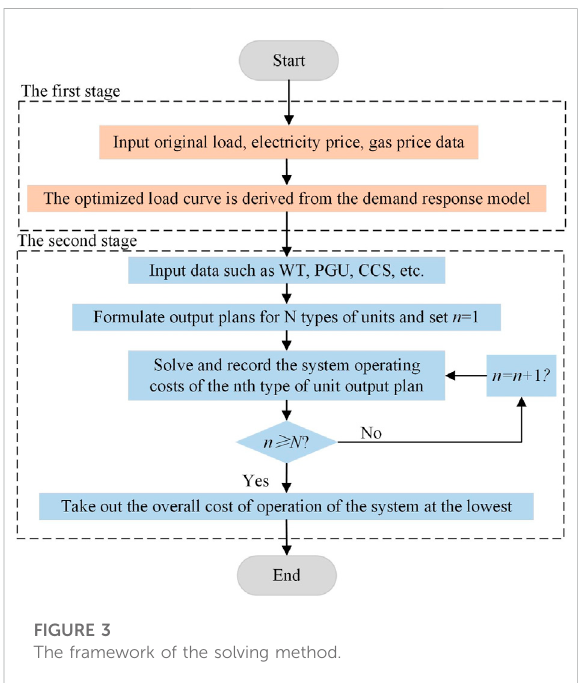
TABLE 1 Parameters of